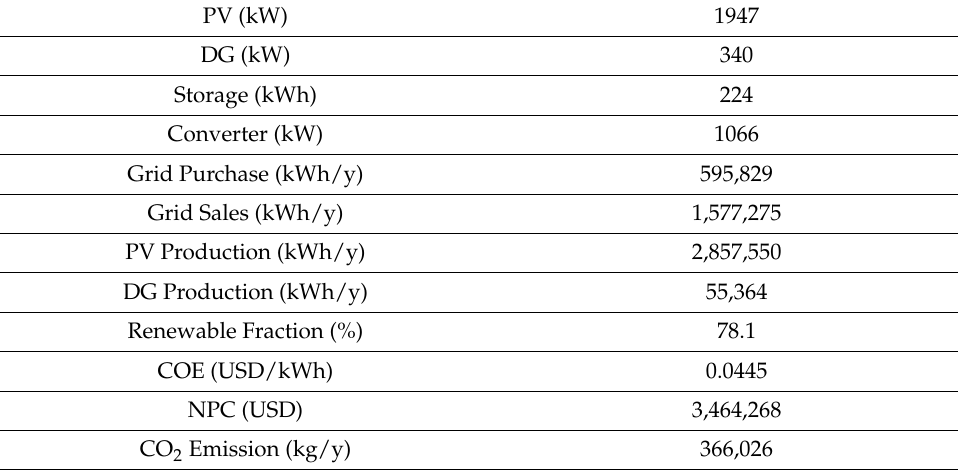
Figure 15. Energy transfer comparison (grid purchase and sale). Table 9. Summarization of real-time rate (annual).